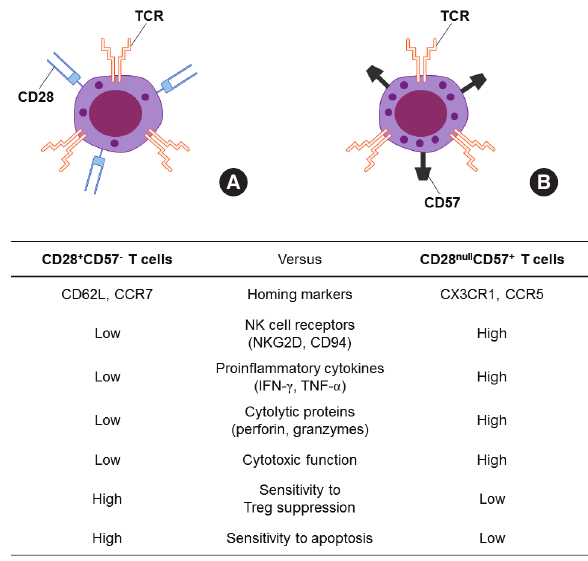
Figure 1. Comparison of CD28 + CD57 - T cells (A) and CD28 null CD57 + senescent T cells (B). INF, interferon; TNF, tumor necrosis